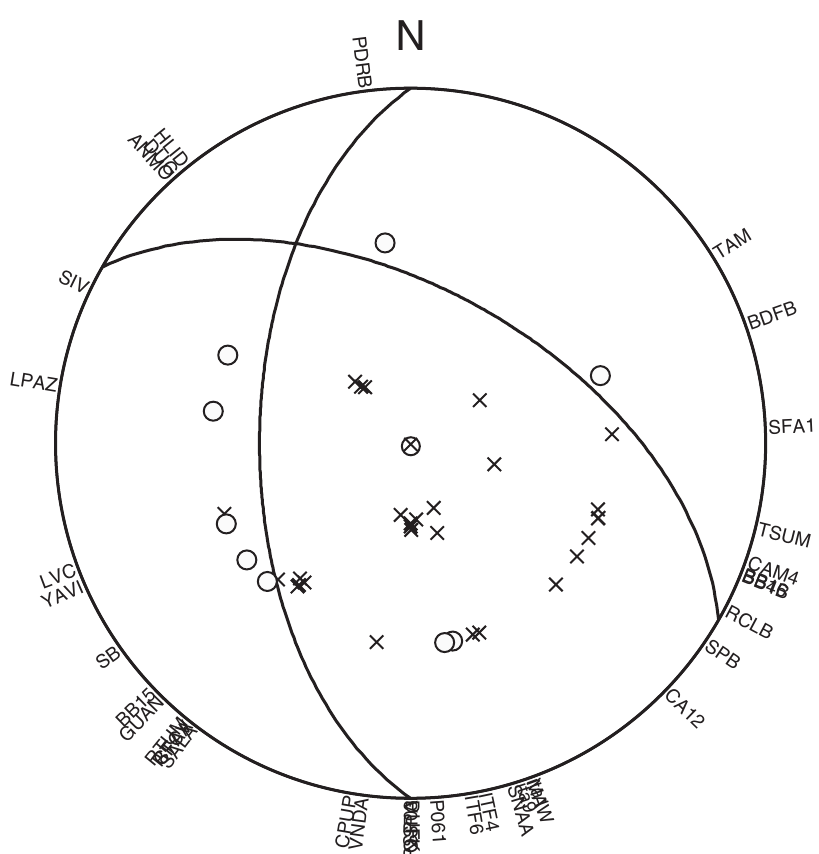
Figure 4 - Stereographic projection (lower hemisphere) of the focal mechanism of the Coxim earthquake of 2009. Crosses indicate compressional P-wave first motion; circles are dilatational motion. The two nodal planes are the two possibilities for the fault plane: N-S or NW-SE. The name of the seismographic stations and the north are also indicated. This mechanism is a reverse fault with transcurrent